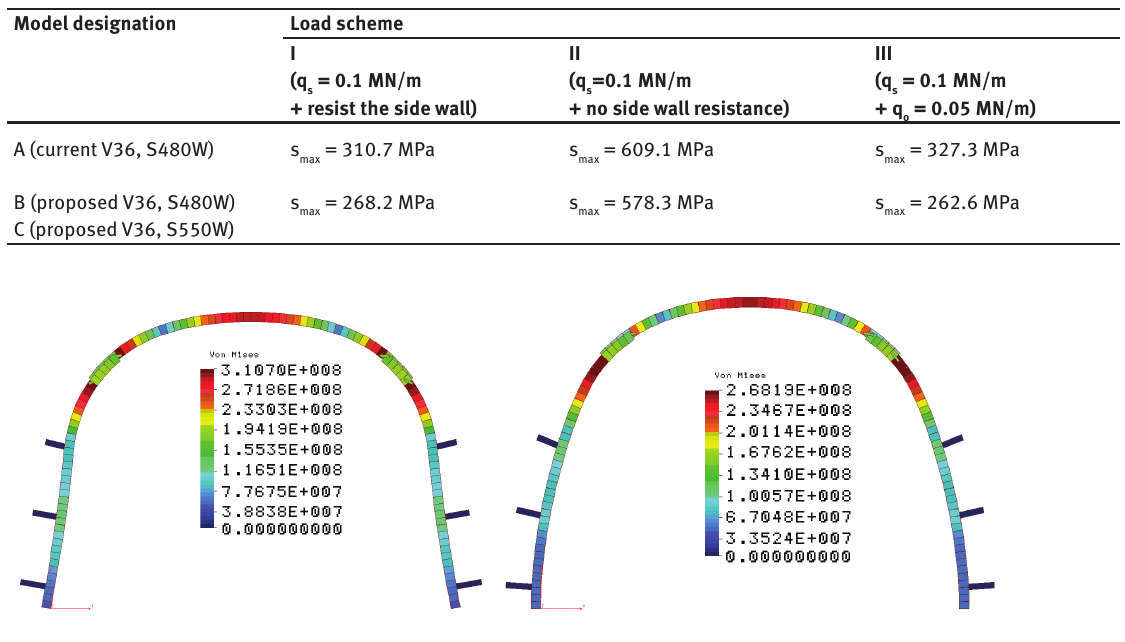
= 0.1 MN/m, stresses in Pa, deformation s